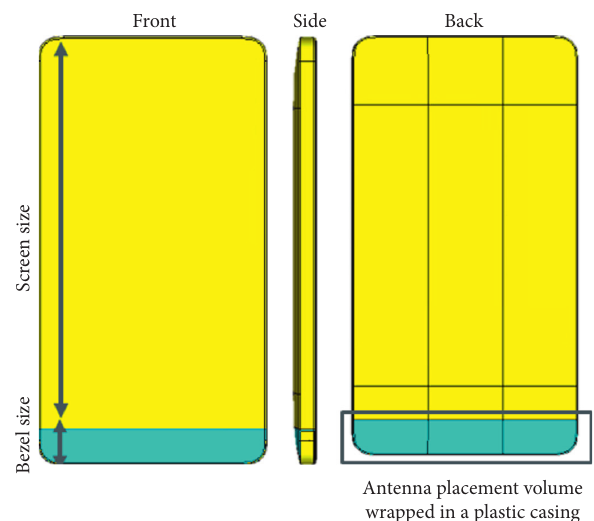
Figure 3: Mobile phone form factor with front, side, and back